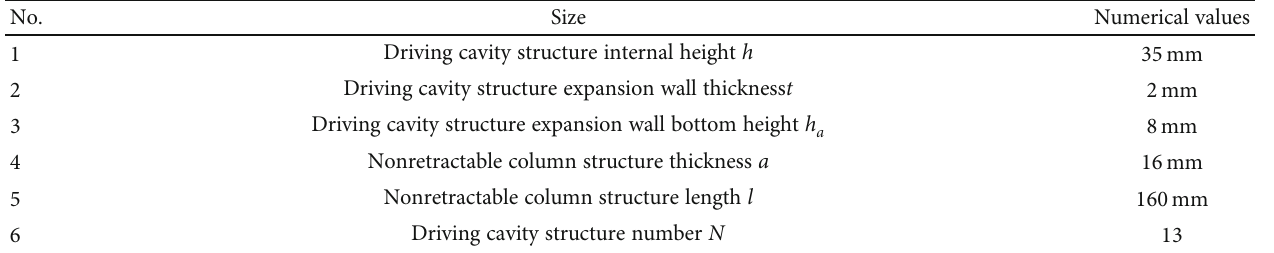
Figure 1: Structure diagram of pneumatic soft-bodied bionic actuator. (a) Overall structure of actuator. (b) Partial view of actuator cross section. (c) End view of actuator. Table 1: Main structural parameters of